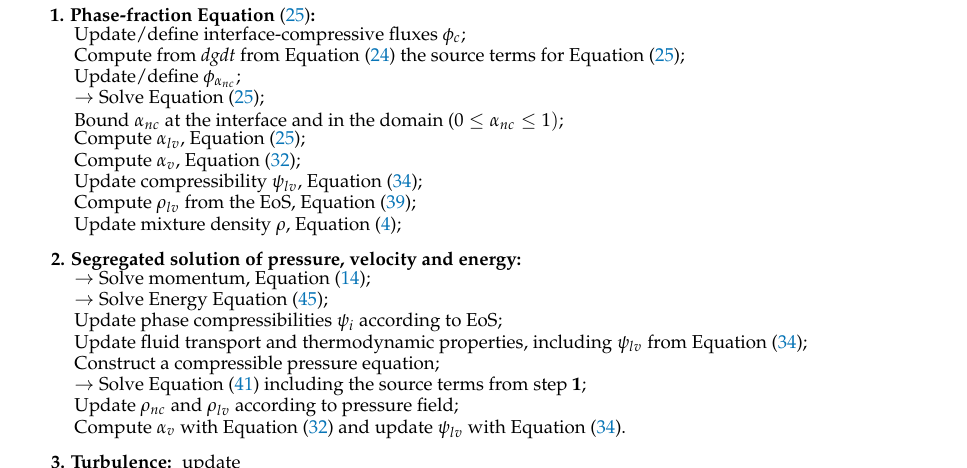
Figure 2. Solution algorithm employed for a single iteration in a time step in the three-phase single- fluid VOF